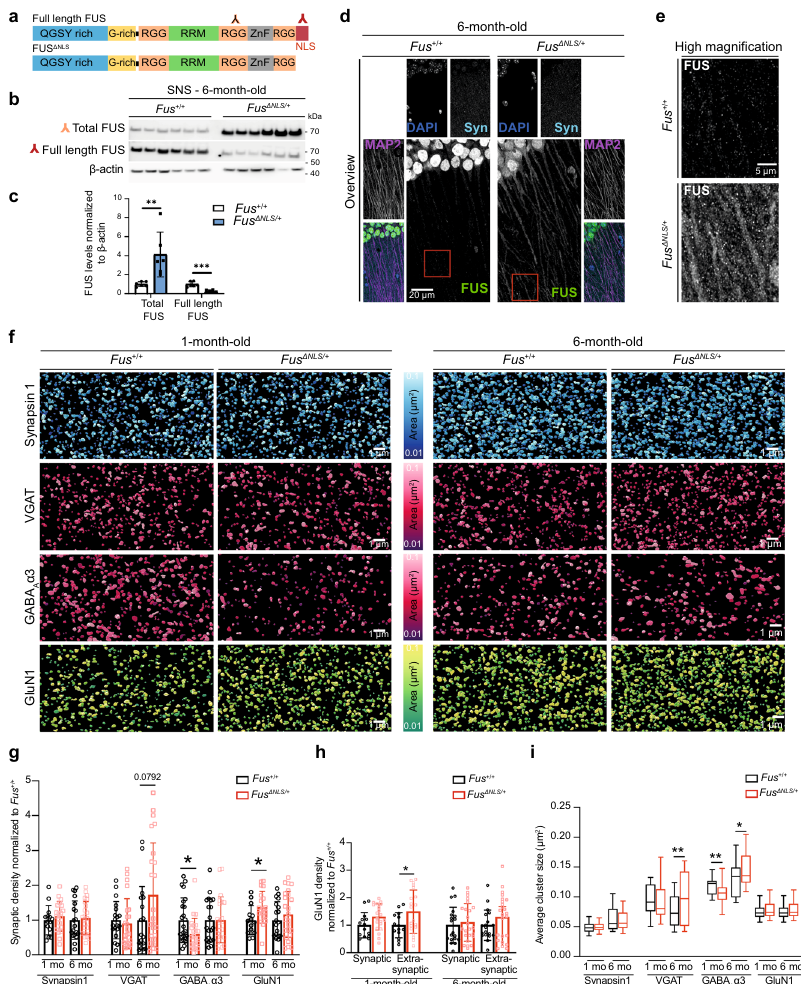
Fig. 3 Increased synaptic FUS localization in Fus Δ NLS/ + mice is accompanied by alterations in GABAergic synapses. a Schematic showing speci fi city of antibodies used for western blot against protein domains of Fused in sarcoma (FUS). b Western blot of total FUS, full-length FUS and actin in synaptoneurosomes isolated from Fus + / + and Fus Δ NLS/ + mice at 6 months of age. Source data are provided as a Source Data fi le. c Quanti fi cation of total FUS ( p -value = 0.0091) and full-length FUS levels ( p -value = 0.001) in synaptoneurosomes from Fus + / + and Fus Δ NLS/ + at 6 months of age. Error bars represent mean±SD. Each dot represents samples prepared from six different mice. n = 6, ** p <0.01, *** p <0.001, two-tailed, unpaired t -test. d Confocal images of the hippocampal CA1 area from 6-month-old mice showing higher level of FUS in the dendritic tree and synaptic compartment in Fus Δ NLS/ + mouse model. On the top, low magni fi cation pictures show the dendritic area of pyramidal cells stained with FUS (green), microtubule-associated protein 2 (MAP2) (dendritic marker, magenta), Synapsin 1 (Syn, synaptic marker, Cyan), and DAPI (Blue). Red box indicates the area imaged in the high magni fi cation images below. n = 5 independent Fus + / + and Fus Δ NLS/ + mice. e Higher magni fi cation equivalent to the area highlighted in red in d . f Representative images of staining using synaptic markers Synapsin 1, Vesicular GABA transporter (VGAT), postsynaptic GABAergic receptors containing α 3 subunit (GABA A α 3), and GluN1 (NMDAR submit) in Fus + / + and Fus Δ NLS/ + at 1 and 6 months of age. Images were generated with Imaris and display volume view used for quanti fi cation with statistically coded surface area. Density and cluster area were analyzed. n = 6 independent Fus + / + and Fus Δ NLS/ + mice at 1 month of age. At 6-month-old, n = 5 independent mice for Fus + / + , n = 6 for Fus Δ NLS/ + . g Graph bar representation of the synaptic density of Synapsin 1, VGAT, GABA A α 3, and GluN1 from Fus + / + and Fus Δ NLS/ + at 1 and 6 months of age. Graph bar showing mean±SD. * p <0.05, two-tailed unpaired t -test. Graphs are extracted from the same analysis shown in Supplementary Fig. 3e, f. The statistical analysis can be found in Supplementary data 2. For 1-month-old group, n = 6 independent mice for Fus + / + and Fus Δ NLS/ + . For 6-month-old group, n = 5 independent mice for Fus + / + , n = 6 for Fus Δ NLS/ + . For Synapsin 1 at 1-month-old, n = 14 fi elds of view for Fus + / + and 866013 synapses analyzed, 20 fi elds of view for Fus Δ NLS/ + with 1,475,455 synapses analyzed. For Synapsin 1 at 6-month-old n = 19 fi elds of view for Fus + / + and 1590276 synapses analyzed, 24 fi elds of view for Fus Δ NLS/ + with 2,138,361 synapses analyzed. For VGAT at 1-month-old, n = 19 fi elds of view for Fus + / + with 713,918 synapses analyzed, 23 fi elds of view for Fus Δ NLS/ + with 782790 synapses analyzed. For VGAT at 6-month-old, n = 18 fi elds of view for Fus + / + with 553020 synapses analyzed, 24 fi elds of view for Fus Δ NLS/ + with 1,273,325 synapses analyzed. For GABA A α 3 at 1-month-old, n = 24 fi elds of view for Fus + / + with 1,062,095 synapses analyzed, 24 fi elds of view for Fus Δ NLS/ + with 634,958 synapses analyzed. For GABA A α 3 at 6-month-old, n = 20 fi elds of view for Fus + / + with 726,881 synapses analyzed, 22 fi elds of view for Fus Δ NLS/ + with 804,732 synapses analyzed. For GluN1 at 1-month- old, n = 14 fi elds of view for Fus + / + with 704,322 synapses analyzed, 20 fi elds of view for Fus Δ NLS/ + with 1,379,868 synapses analyzed. For GluN1 at 6-month-old, n = 19 fi elds of view for Fus + / + with 1,267,271 synapses analyzed, 24 fi elds of view for Fus Δ NLS/ + with 1,866,397 synapses analyzed. h Colocalization analysis of GluN1 with Synapsin 1 to identify synaptic NMDAR (GluN1) and extrasynaptic NMDAR. Results were normalized by the control of each group. Graph bar showing mean±SD. * p <0.05., two-tailed unpaired t -test. ‘ n ’ values are as indicated in g . i Box and Whiskers representation (centered on the median with min to max value) of the average cluster area for each marker (Synapsin 1, VGAT, GABA A α 3, and GluN1) from 1- month and 6-month-old Fus + / + and Fus Δ NLS/ + mice. Box showing Min to Max, * p <0.05 ** p <0.01, two-tailed, unpaired t -test. ‘ n ’ values are as indicated in g . Graphs are extracted from the same analysis shown in Supplementary Fig. 3f – i. The statistical analysis can be found in Supplementary data 3. NATURE COMMUNICATIONS| (2021) 12:3027